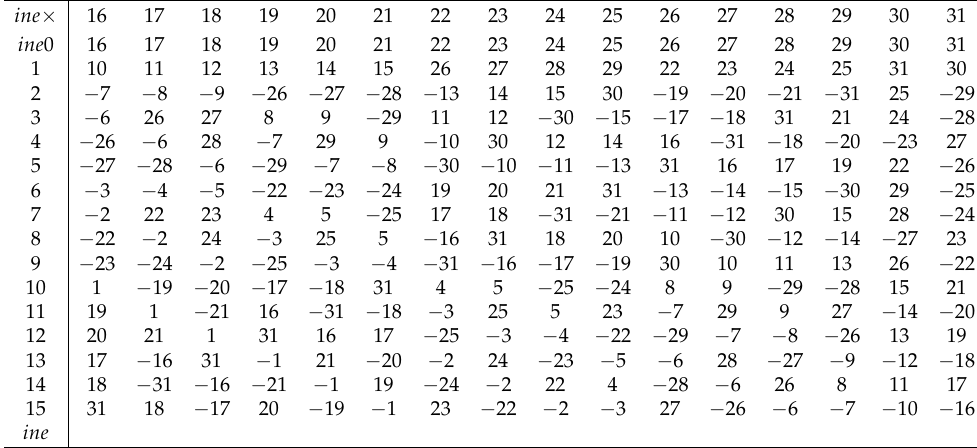
Table 3. Multiplication rules of Kaluza numbers for e 16 , e 17 , . . . , e 31 and e 0 , e 1 , . . . , e 15 (elements